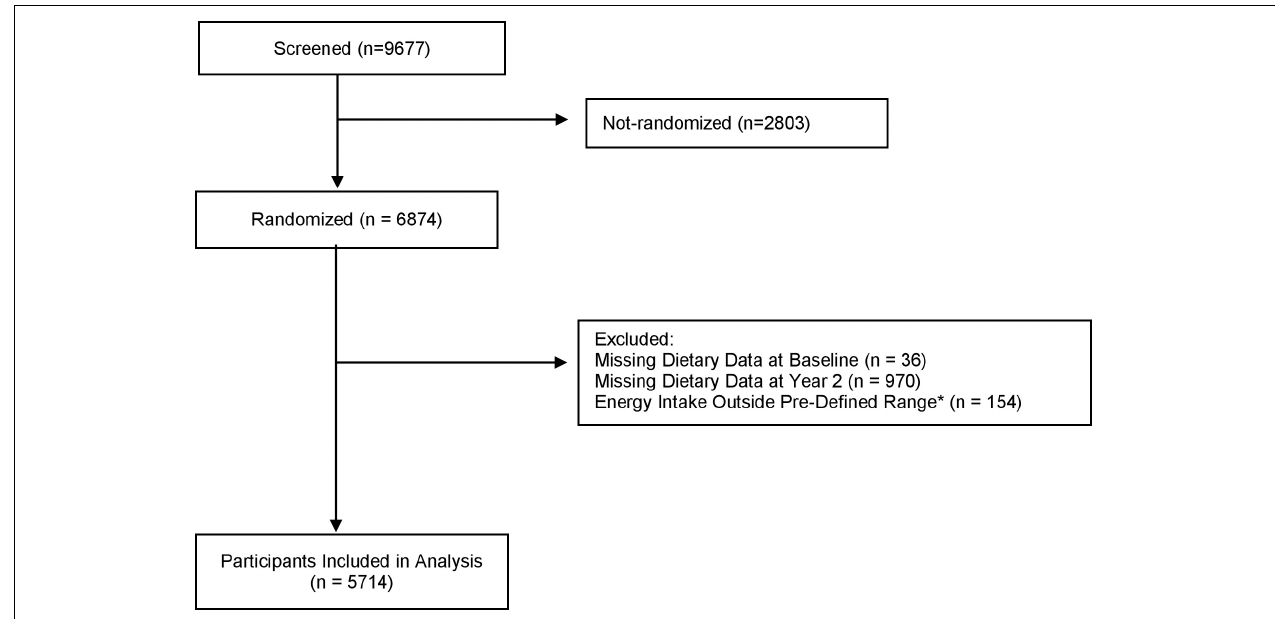
FIGURE 1 | Flow diagram of participants for the analysis of a priori dietary pattern adherence and cognitive performance in the PREDIMED-Plus trial. *Energy intakes outside pre-specified limits were identified as ≤ 800 to ≥ 4,000 Kcal/d for men and ≤ 500 to ≥ 3,500 Kcal/d for women.